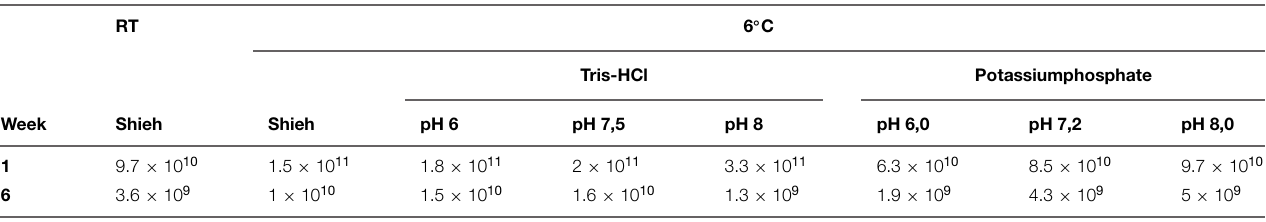
TABLE 1 | Phage FCL-2 stability as plaque forming units (PFU) per mL during 6-week storage.